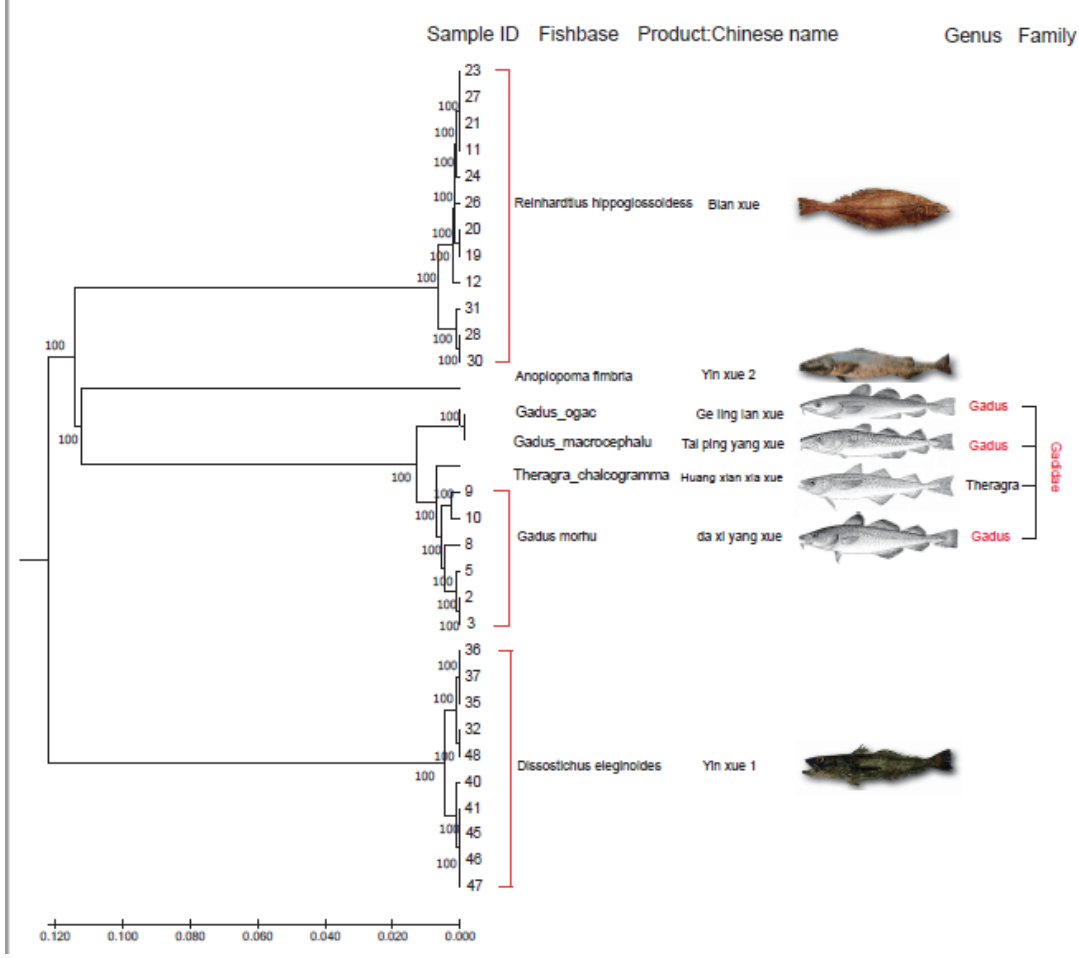
Figure 1. Bayesian tree using COI sequences obtained from common fish species sold as cod in a Chinese supermarket. The fish images were retrieved from Food and Agriculture Organization of the United Nations (FAO) and the codfish name was obtained from Fishbase.